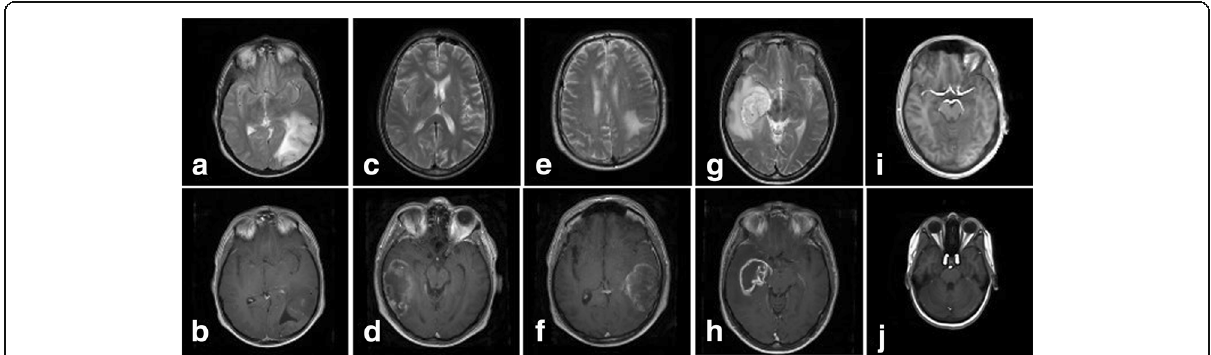
Fig. 4 Example slices from the static viewing task. Images ( a ) (T2) and ( b ) (T1) are from patient 1, ( c ) (T2) and ( d ) (T1) are from patient 2, ( e ) (T2) and ( f ) (T1) are from patient 3, ( g ) (T2) and ( h ) (T1) are from patient 4 and ( i ) (T2) and ( j ) (T1) from are from patient 5